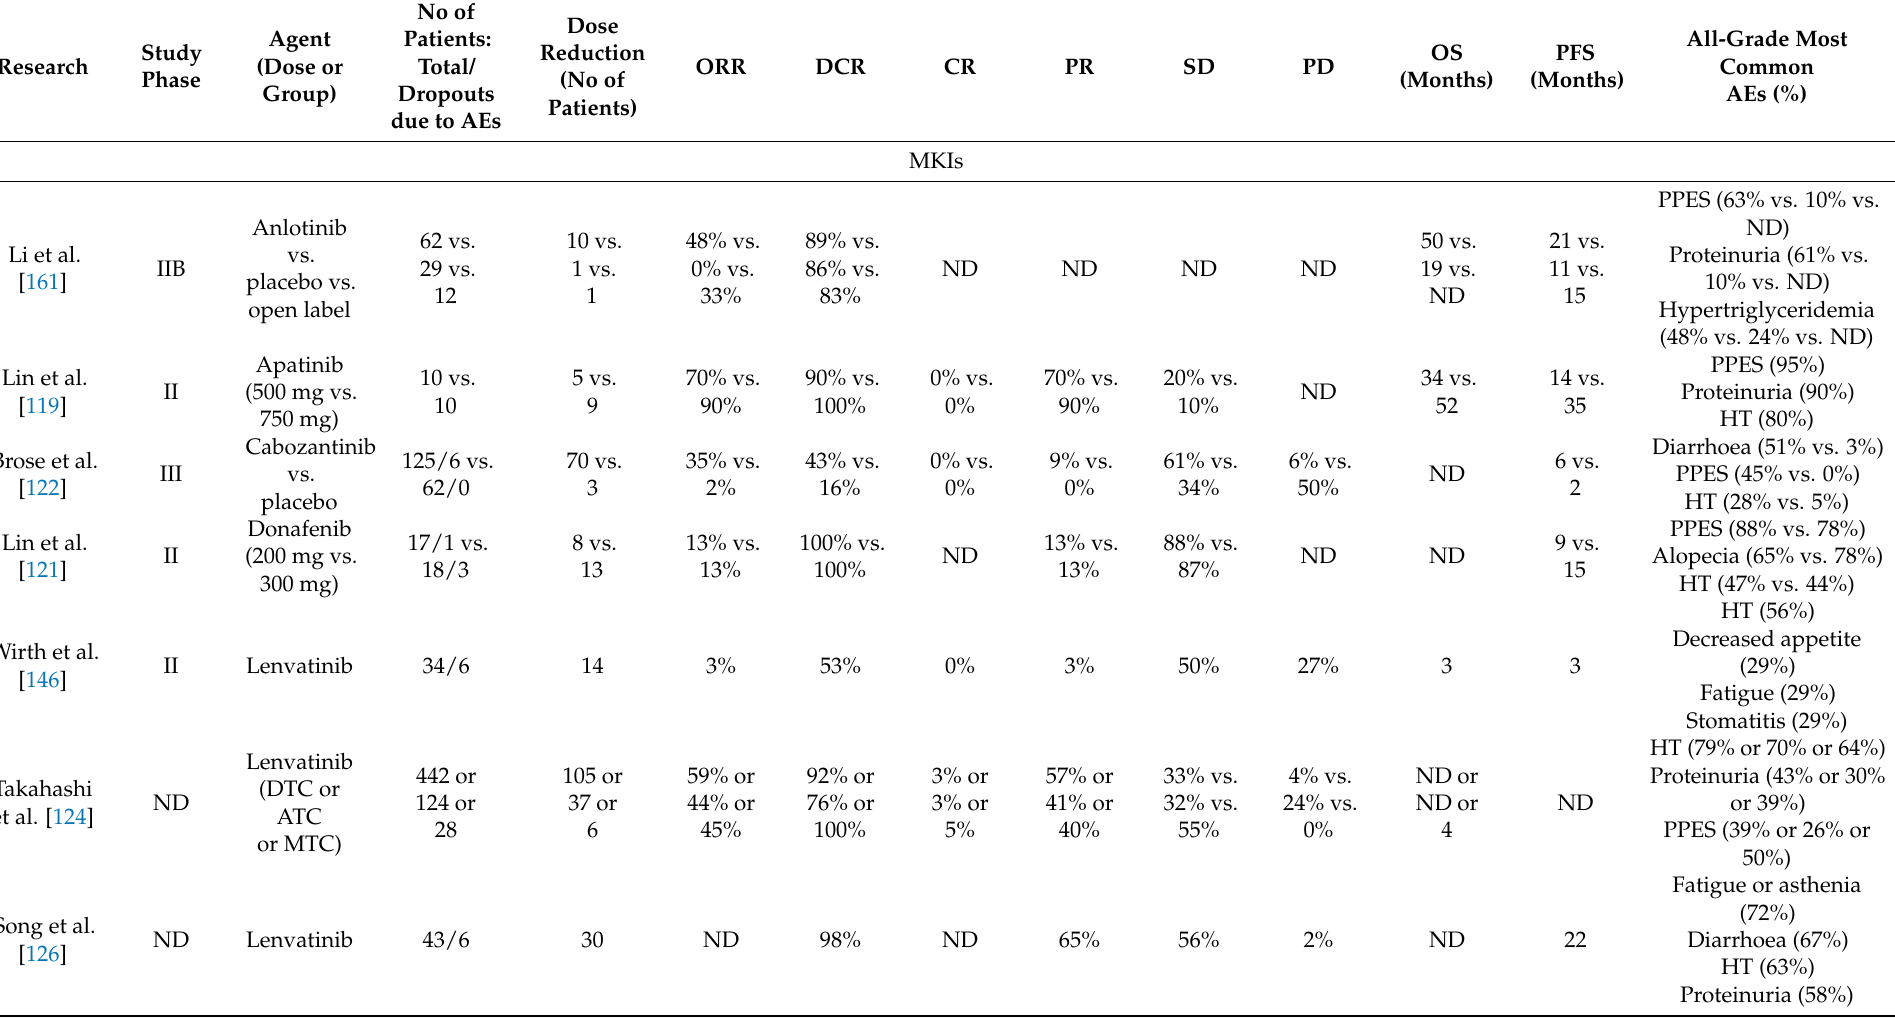
Table 5. Most common adverse events (AEs) reported for kinase inhibitors in TC treatment over the past two years.